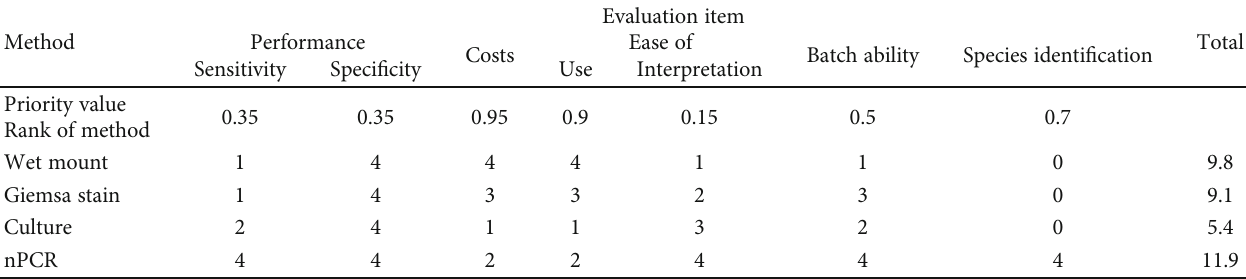
Table 4: Analytical hierarchy process of the overall ranking of di ff erent diagnostic techniques under study.